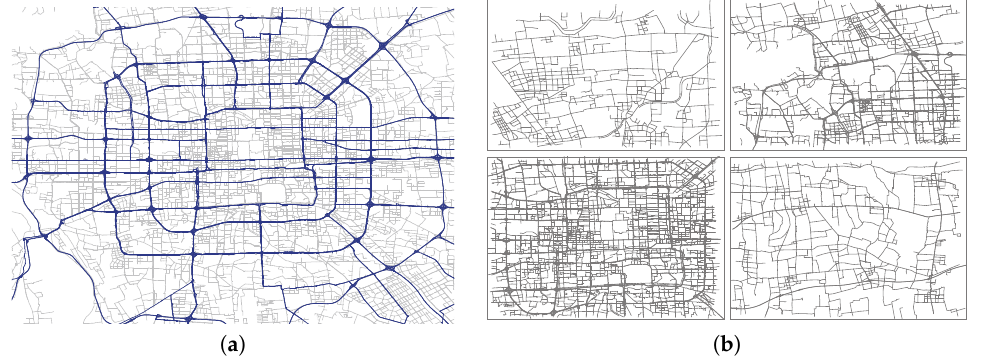
Figure 8. Map and Data Visualization. ( a ) Beijing Urban Area; ( b ) Selected